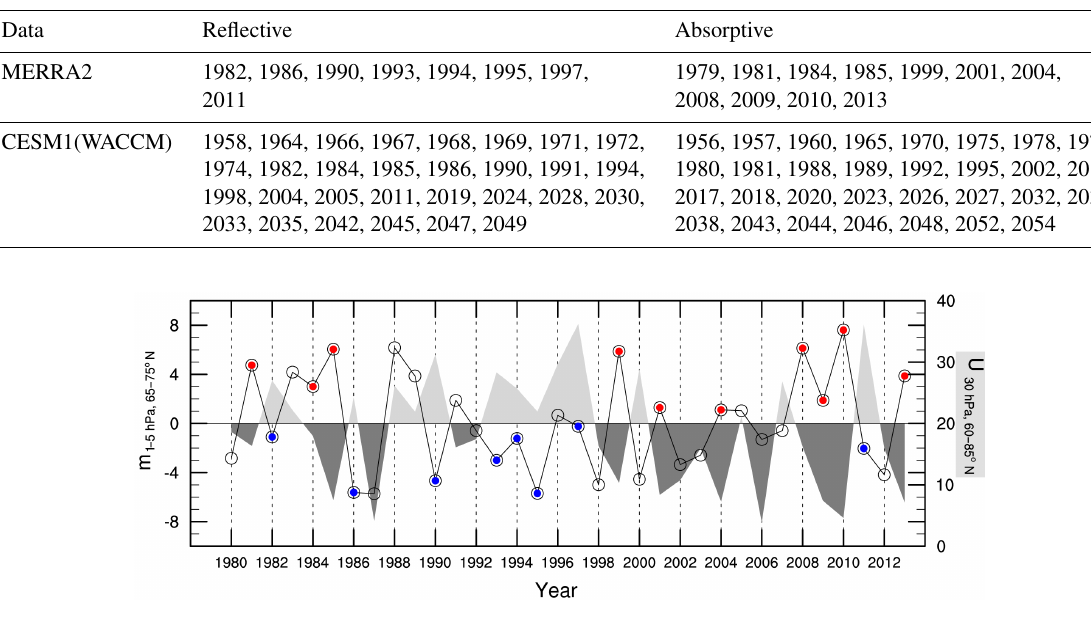
Table 2. The reflective and absorptive years defined based on the vertical reflecting surface ( m< 0) and U 30hPa in JFM.